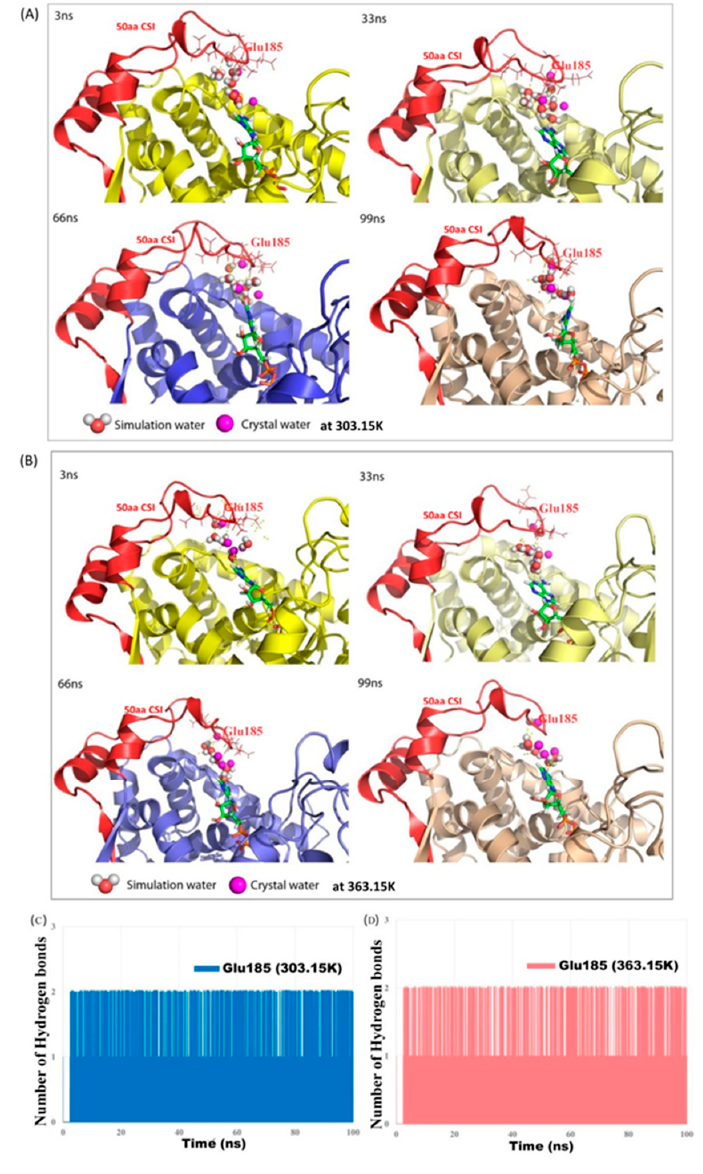
Figure 5. Snapshots from di ff erent time intervals extracted from the 100 ns molecular dynamic (MD) trajectories of Tm SecA ( + CSI) showing the coordinates of water molecules from the simulation (red and white spheres) that constantly occupy the location near the backbone of residue Glu185 from the 50 aa CSI in Tm SecA at ( A ) 303.15 K, and ( B ) 363.15 K. Each of the extracted structures representing the di ff erent time scale is represented with di ff erent colors and the times are indicated in the snapshots. The magenta spheres represent the coordinates for crystallographic water molecules which are from the corresponding region in the crystal structure of Tm SecA and they are superimposed to each of the extracted structures to show the occupancy of the simulation water molecules of that region. Any hydrogen bonds formed between simulation water molecules and adenine group of ADP or residues from the insert are shown as yellow dash lines. Other randomly picked snapshots at di ff erent time intervals that show the occupancy and interaction of water molecules with residue (Glu185) from 50 aa CSI and ADP in Tm SecA are provided in Figure S4A,B. ( C ) Trajectories showing the time evolution of the number of hydrogen bond interactions formed between Glu185 residue backbone atom (O) from the 50 aa CSI and water molecules that are within 4 Å of Glu185 at 303.15 K (blue) and ( D ) 363.15 K (red), calculated over the 100 ns time period.